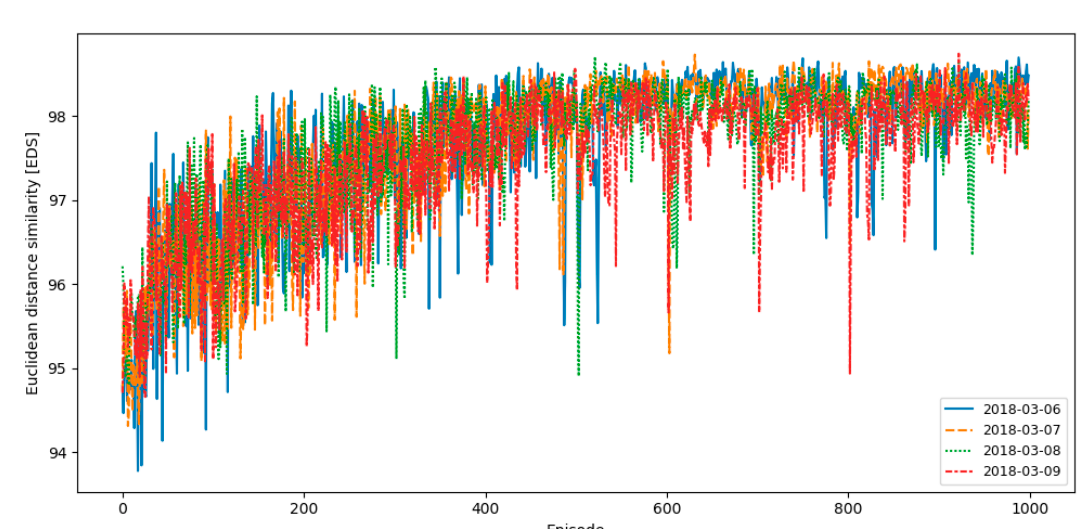
Figure 9. Euclidean distance similarity trend curve per episode.